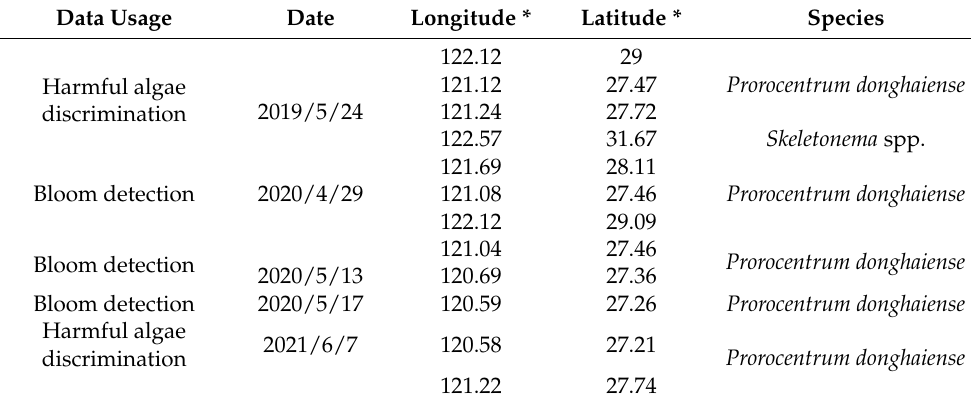
Table 1. East China Sea summer bloom events 2019–2021.